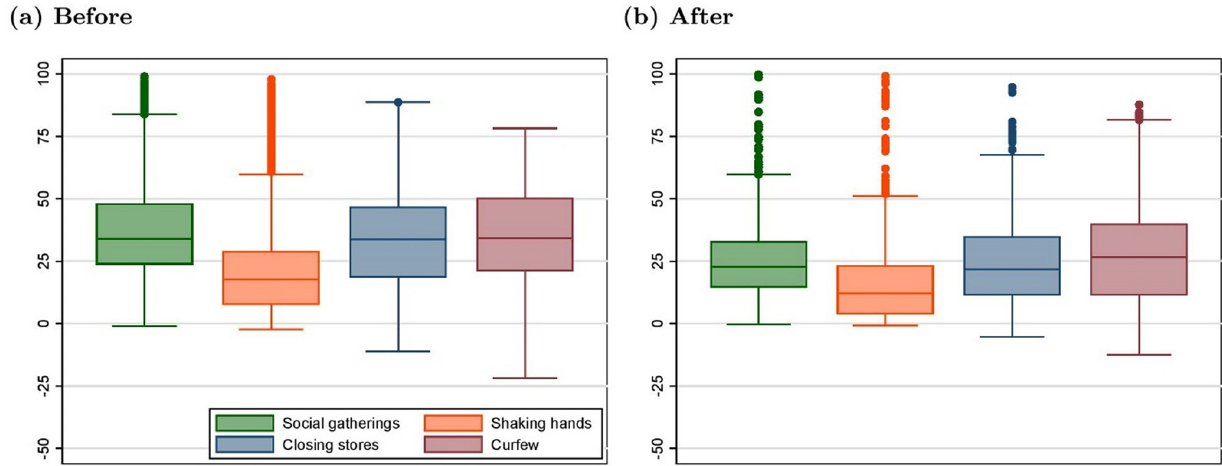
Fig 4. Before-after comparison of misperceptions in the UK. Discrepancy between the norm and the individual perception of the norm in the UK before and after March 23. The horizontal line in the middle of the box characterizes the median. The upper (lower) ends of the box characterizes the 75th (25th) percentile. The upper (lower) ends of the vertical lines are the upper (lower) adjacent values. Points above (below) are outliers.